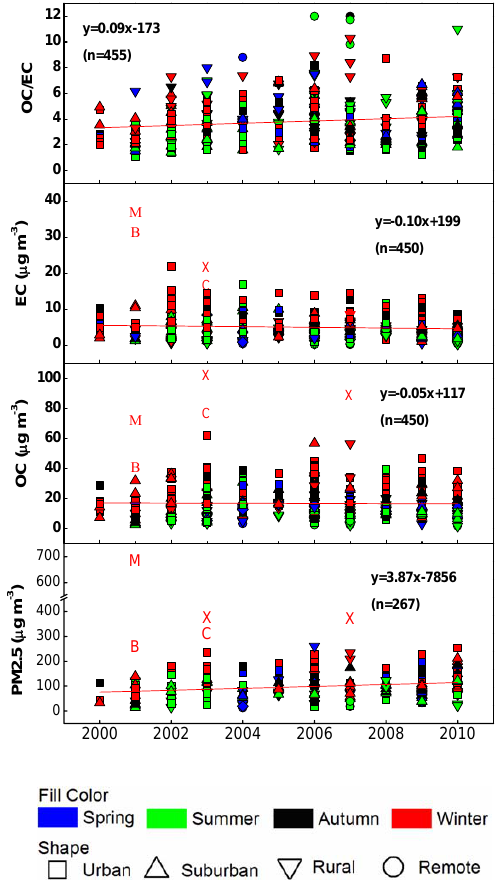
Figure 8. Inter-annual trends of concentrations of OC, EC and PM 2 . 5 , and ratios of OC to EC from 2000 to 2010 based on ground observations from various studies. Five data points (B: Beijing; M: Miyun; X: Xi’an; C: Chongqing) are excluded from the linear re- gression analysis due to the extremely high concentrations observed during heavy haze pollution